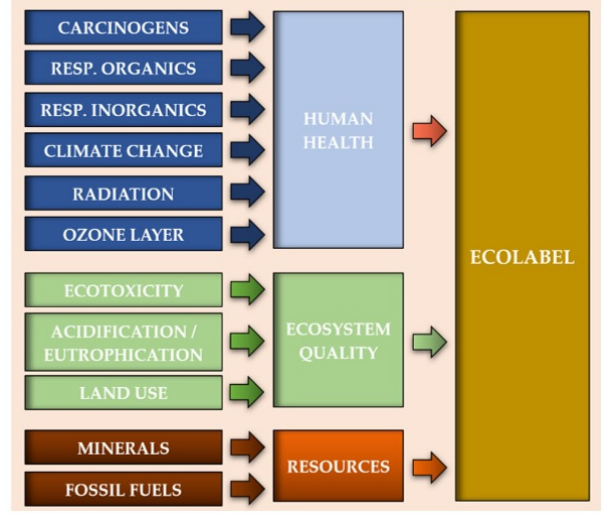
Figure 4. The method of data aggregation in the Eco-indicator 99 method.